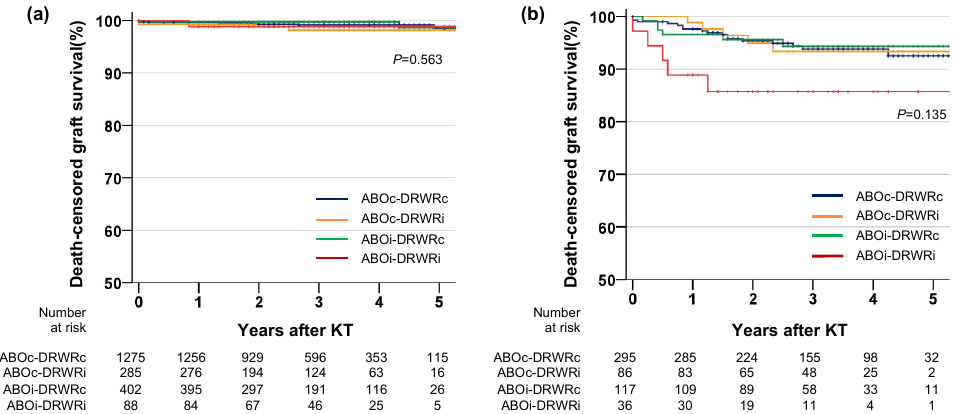
Figure 4. Graft survival among patients who did or did not experience BPAR. ( a ) Did not experienced BPAR, ( b ) experienced BPAR. BPAR, biopsy-proven acute rejection; KT, kidney transplantation.